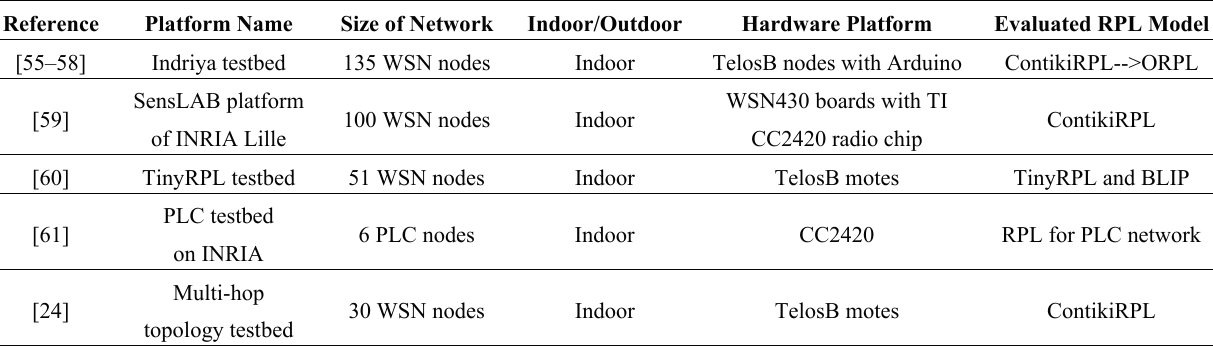
Table 2. Existing real world testbeds for the evaluation of RPL